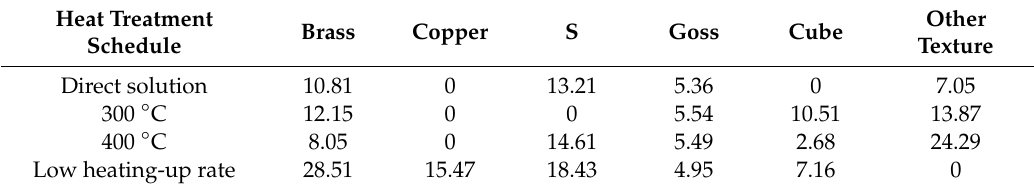
Figure 5. ODF images of solutionized samples after di ff erent annealing treatments. ( a ) Direct solution; ( b ) 300 ◦ C; ( c ) 400 ◦ C; and ( d ) low heating-up rate. Table 3. Textures volume fraction of solutionized samples after di ff erent annealing treatments